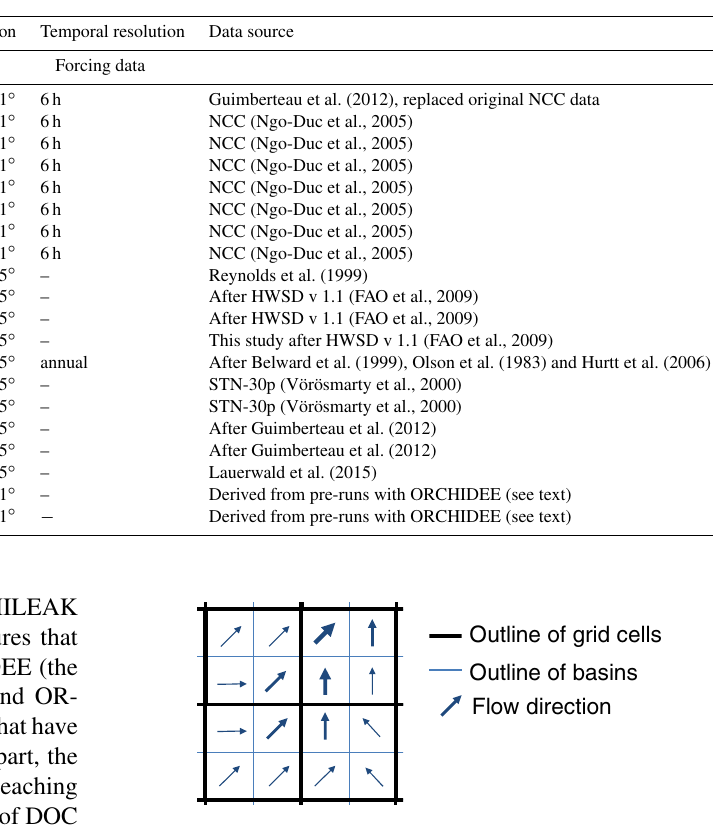
Figure 2. Schematic representation of 4 ORCHIDEE grids x at 1 ◦ spatial resolution for a simulation using a river routing scheme run- ning at 0.5 ◦